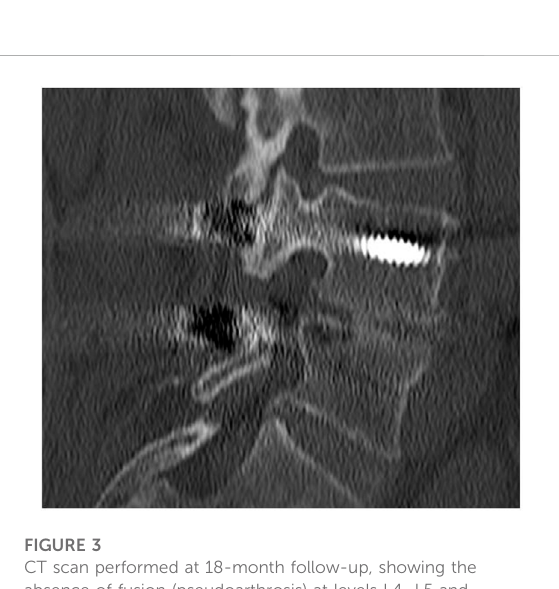
FIGURE 3 CT scan performed at 18-month follow-up, showing the absence of fusion (pseudoarthrosis) at levels L4 – L5 and L5 – S1 where SintLife was